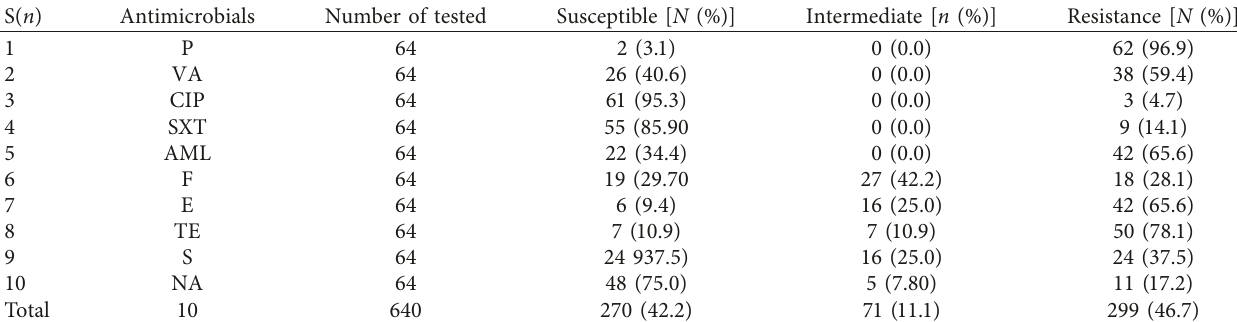
Table 3: Antimicrobial susceptibility profile of staphylococcal isolates ( n � 64).